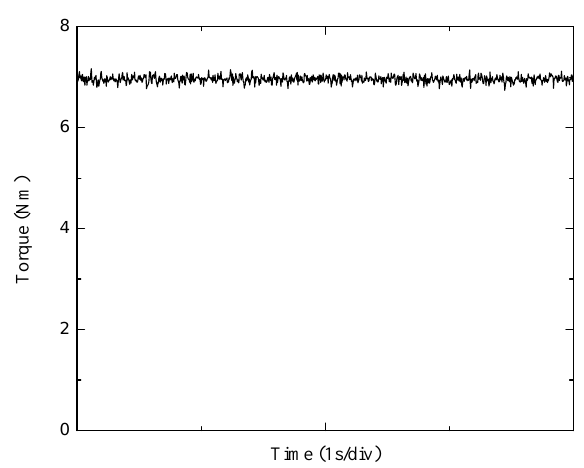
Figure 18. Torque response under 7 N · m load with 25 ◦ .